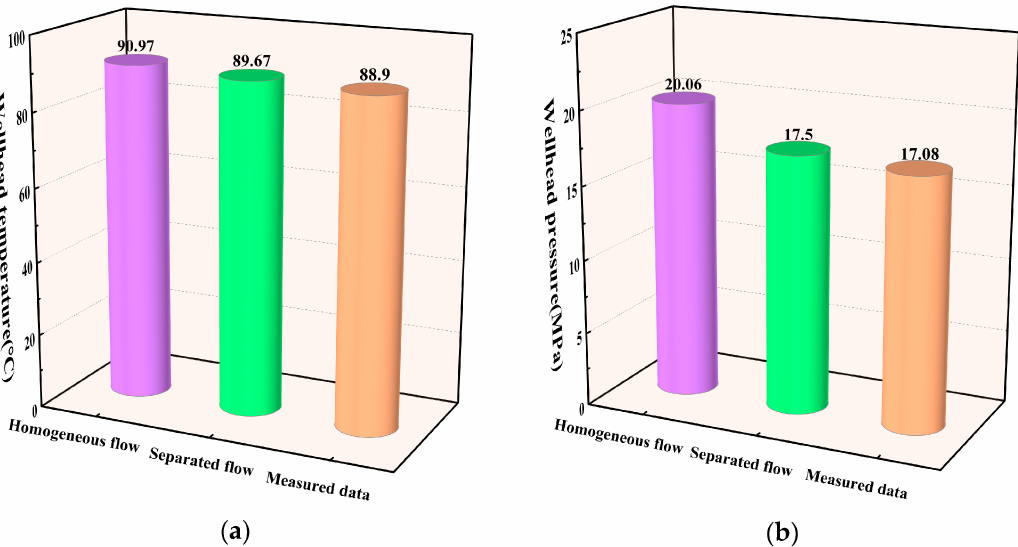
Figure 6. Comparison between calculation results and measured data. ( a ) Wellhead temperature. ( b ) Wellhead pressure.